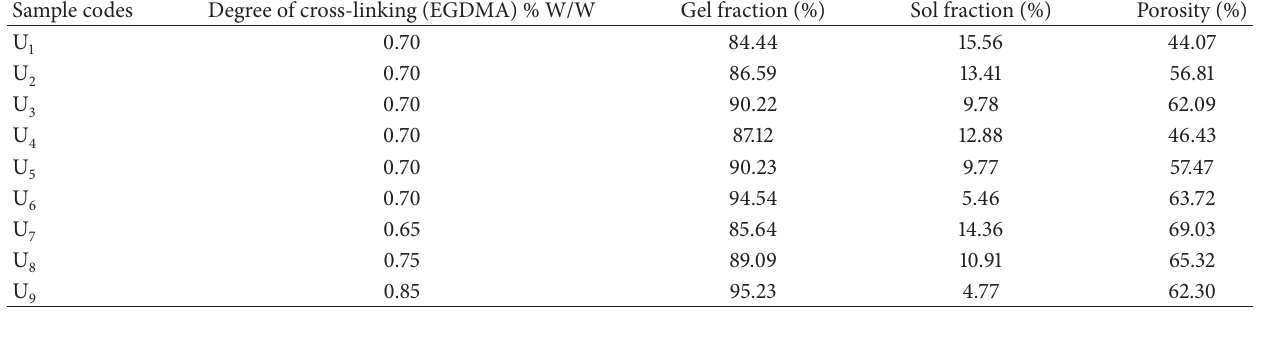
Table 4: Sol-gel fraction analysis and porosity measurement of different formulations of AA/Gelatin hydrogels. Sample codes